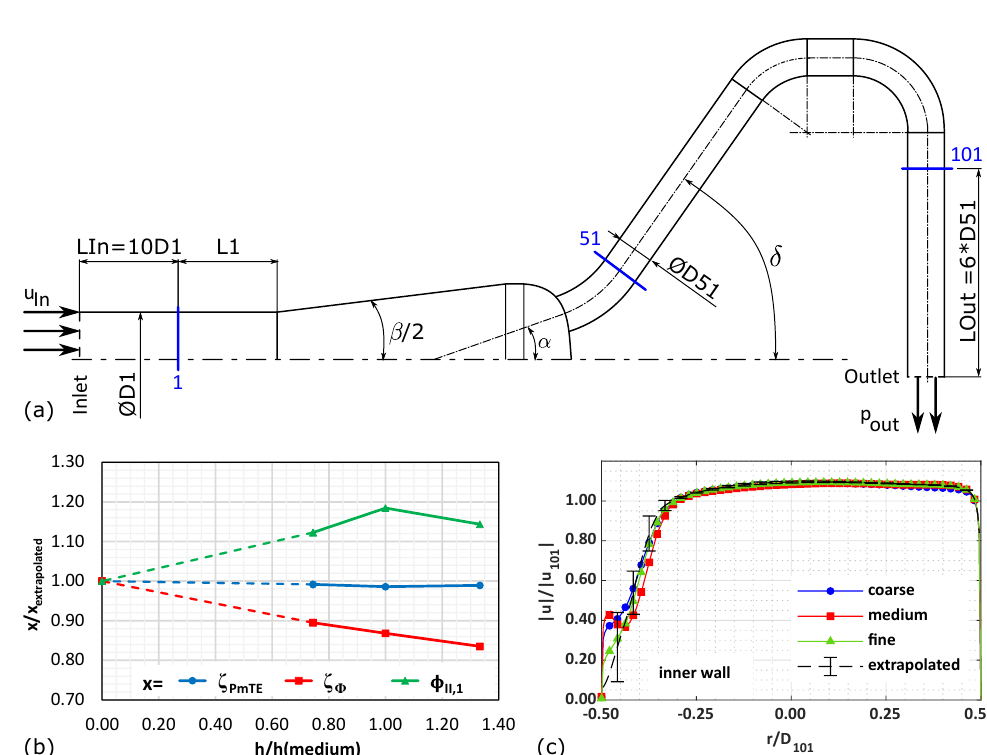
Figure 4. Computational domain ( a ), results of mesh study for integral values ( b ), and local velocities ( c